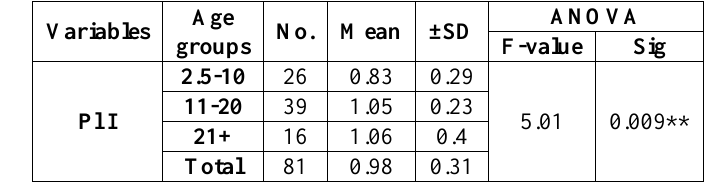
Table 4: Calculus index (mean and standard deviation) among patients with Juvenile Idiopathic Arthritis according to age Age group Variable